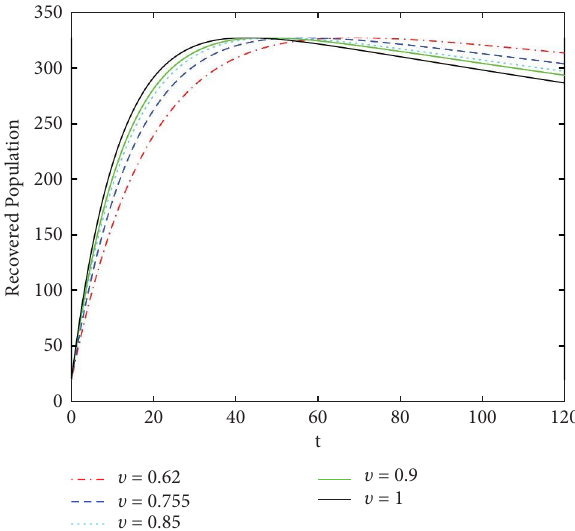
Figure 19: Te dynamics of recovered human population for various fractal orders π and for fractional order υ � 0 .